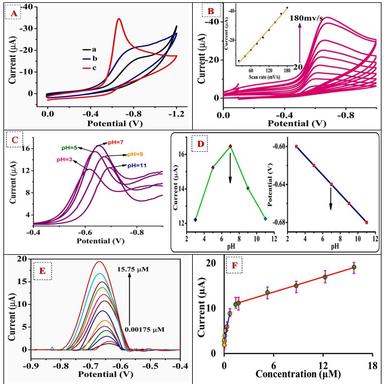
A) CVs of bare GCE (a), GQDs@GCE (b), GQDs@La3+@ZrO2 (c) in the presence of 12 μM of FLT in 0.1 M PBS (pH 7.0) at a scan rate of 30 mV/ s; B) CVs GQDs@La3+@ZrO2/GCE in the presence of 12 μM of FLT at different scan rates from 20 to 180 mVs− 1 in 0.1 M PB S (pH 7.0); C) SWV of GQDs@La3+@ZrO2/GCE in the presence of 12 μM of FLT containing different pH solution from 3.0 to 11.0. D) Linear plot of pH vs. potential and cathodic peak current; E) SWV obtained from different concentration of FLT from 0.00175 μM to